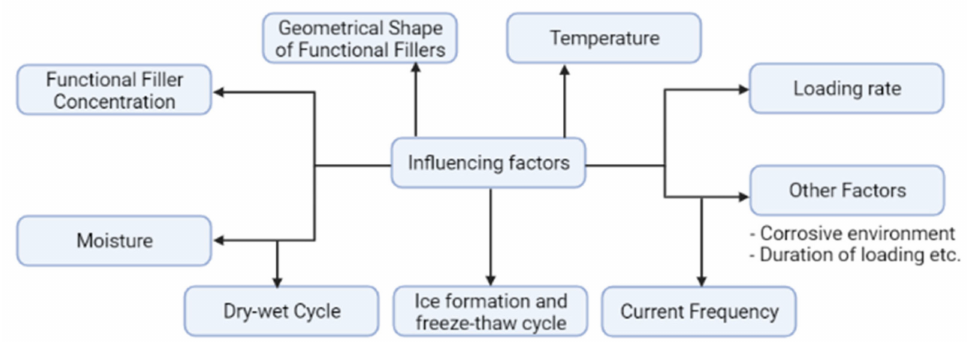
Figure 9. Factors influencing the electrical